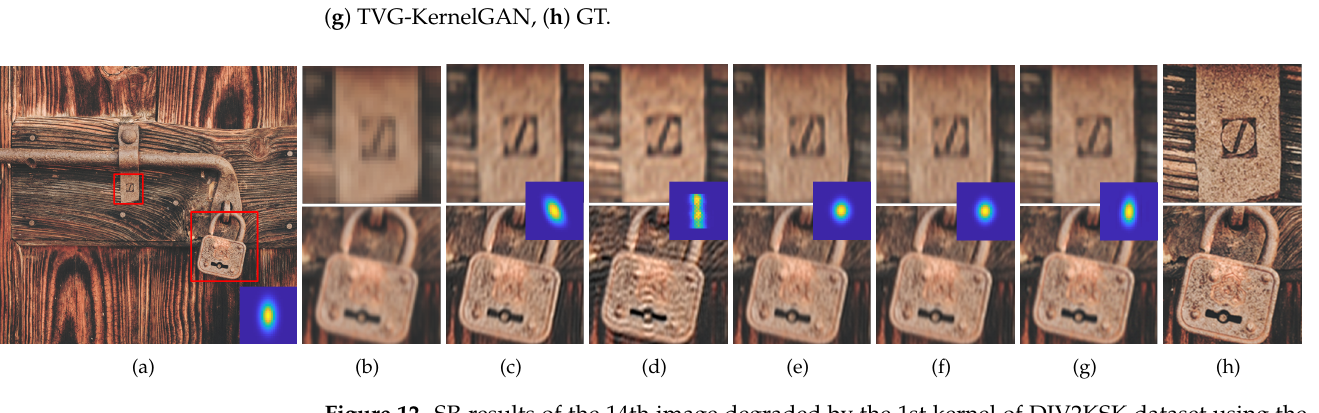
Figure 12. SR results of the 14th image degraded by the 1st kernel of DIV2KSK dataset using the estimated kernels for scale factor of × 4. The first row is the ZSSR results and the second row is the results of solving Equation (2). From ( c ) to ( g ), the estimated kernels are shown in the middle of each column. ( a ) GT image and kernel, ( b ) LR, ( c ) KernelGAN [20], ( d ) FKP [21], ( e ) E-KernelGAN [22],